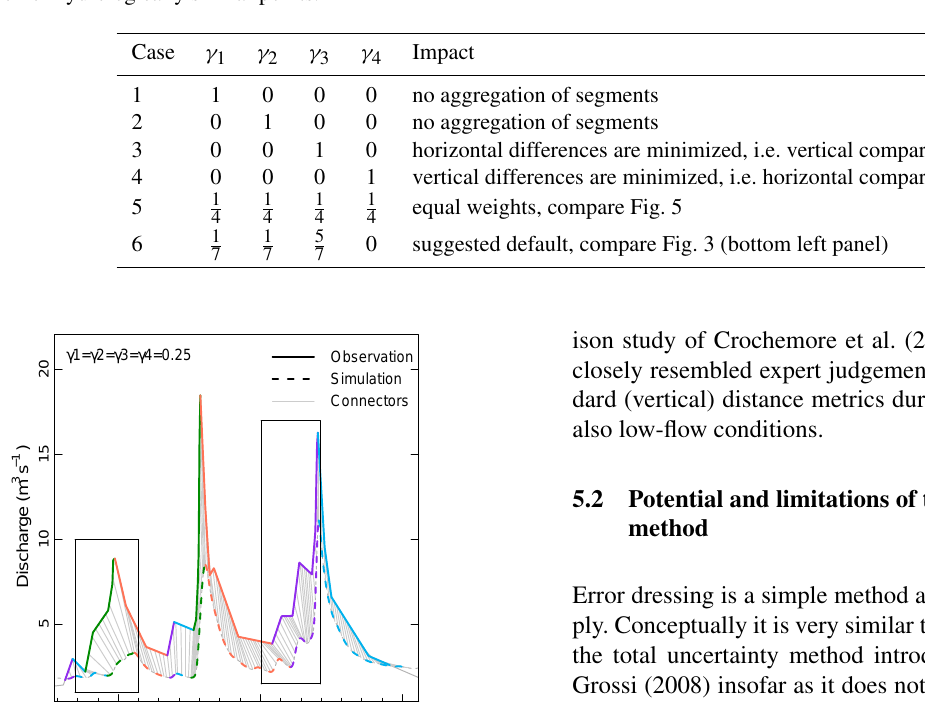
Table 1. Qualitative description of the impact of the different weighting factors of the objective function θ (Eq. 2), which governs the coarse- graining procedure. Note: none of the extreme parametrizations described by the cases nos. 1–4 is meaningful as any of them prevent the comparison of hydrologically similar points.